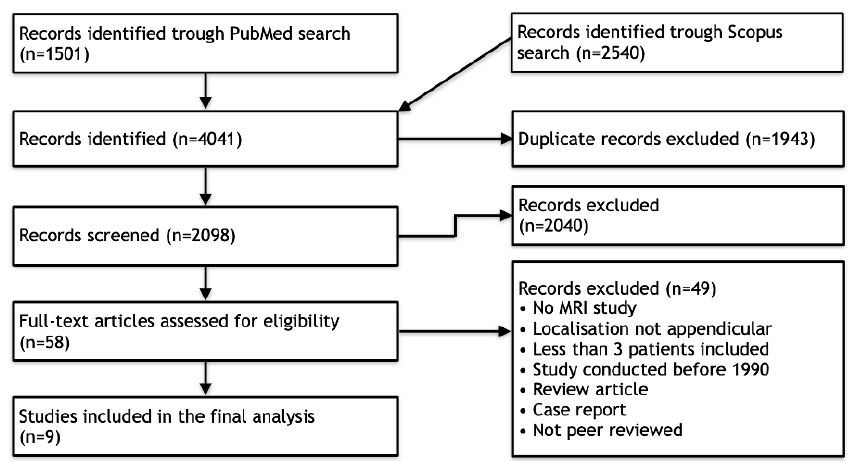
Figure 1. Preferred Reporting Items for Systematic Reviews and Meta-Analyses (PRISMA) flowchart.